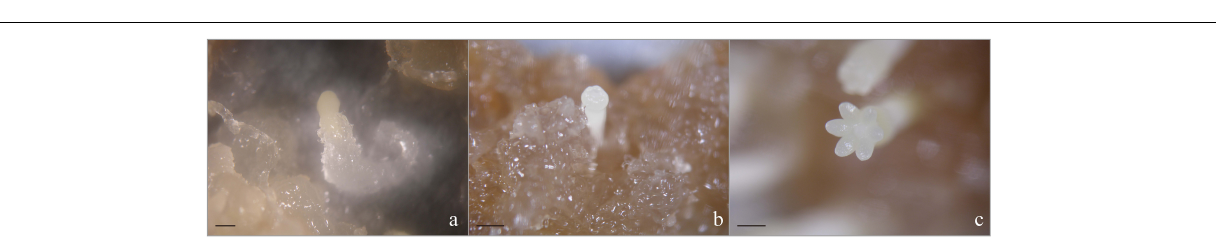
FIGURE 7 | Morphology of somatic embryos at different developmental stages in P. elliottii × P. caribaea. ESMs after culturing on the solid mature medium for 14 (a) , 21 (b) , and 35 (c) days. Scale bar = 1 mm.